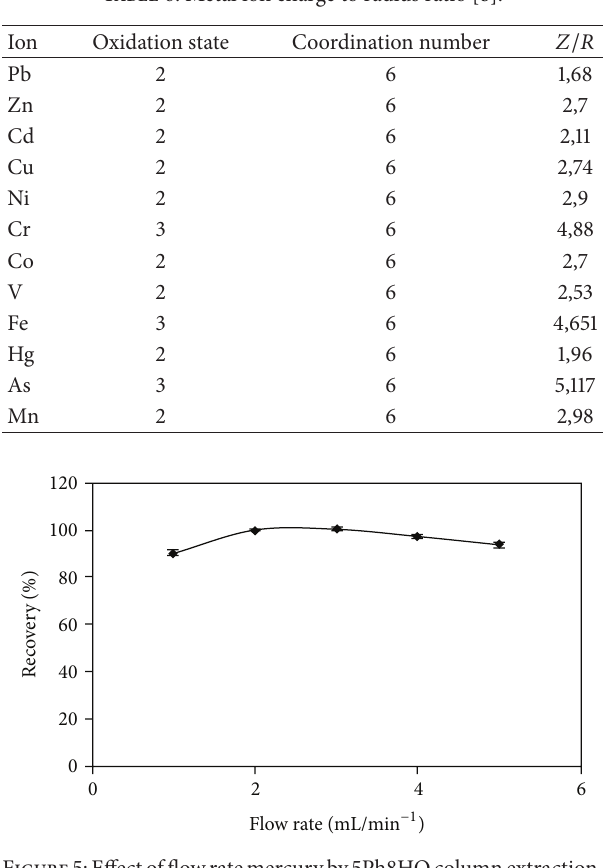
Figure5:Effectofflowratemercuryby5Ph8HQcolumnextraction. Conditions: [Hg 2+ ]: 2ng mL −1 , 𝑉 (50mL), pH 4, and eluent: 5M HCl + 5% CS(NH 2 ) 2 /10mL. Bars represent standard deviation for two replicates.